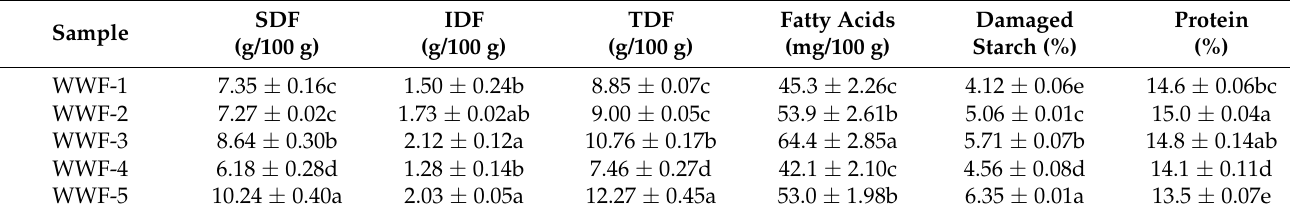
Table 1. Chemical composition of WWFs obtained from different milling methods.